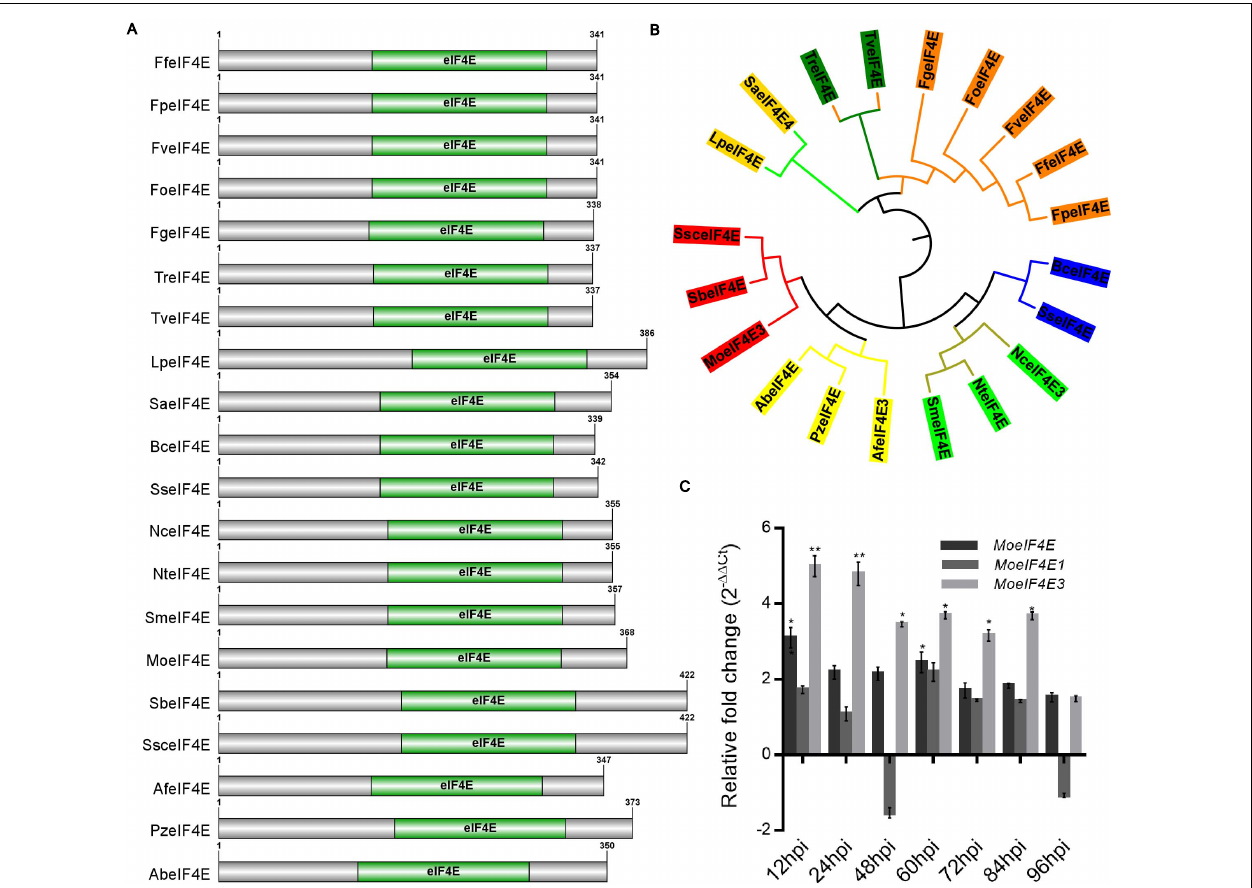
FIGURE 1 | Domain architecture and phylogeny of M. oryzae eIF4E3 containing proteins. (A) Domain architecture of different fungal proteins containing eIF4E3 domains. (B) Shows maximum likelihood phylogeny constructed entirely for eIF4E3 domain sequence (amino acid) across different fungal species (Lp: Lomentospora prolificans , Sa: Scedosporium apiospermum, Tr: Trichoderma reesei , Tv: Trichoderma virens, Fg: Fusarium graminearum , Fo: Fusarium oxysporum , Fv: Fusarium verticillioides , Ff: Fusarium fujikuroi , Fp: Fusarium proliferatum, Bc: Botrytis cinerea, Ss: Sclerotinia sclerotiorum, Nc: Neurospora crassa,